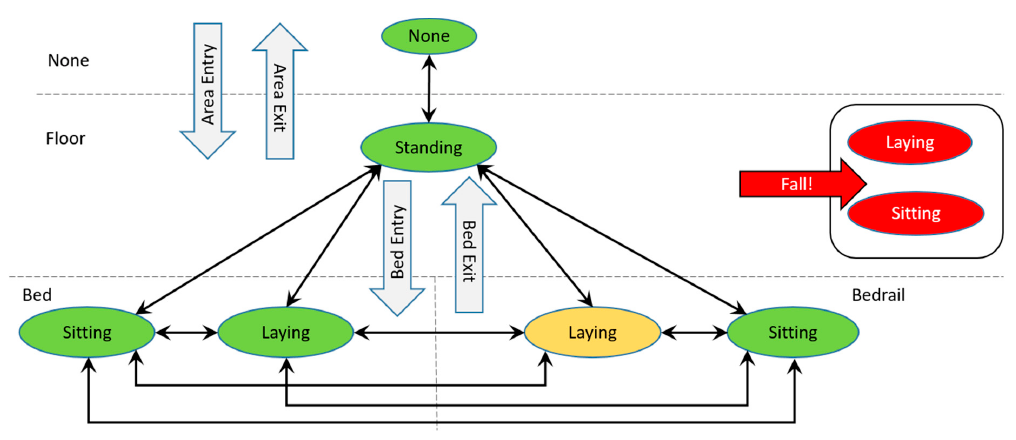
Figure 4. Transitions and events identification.